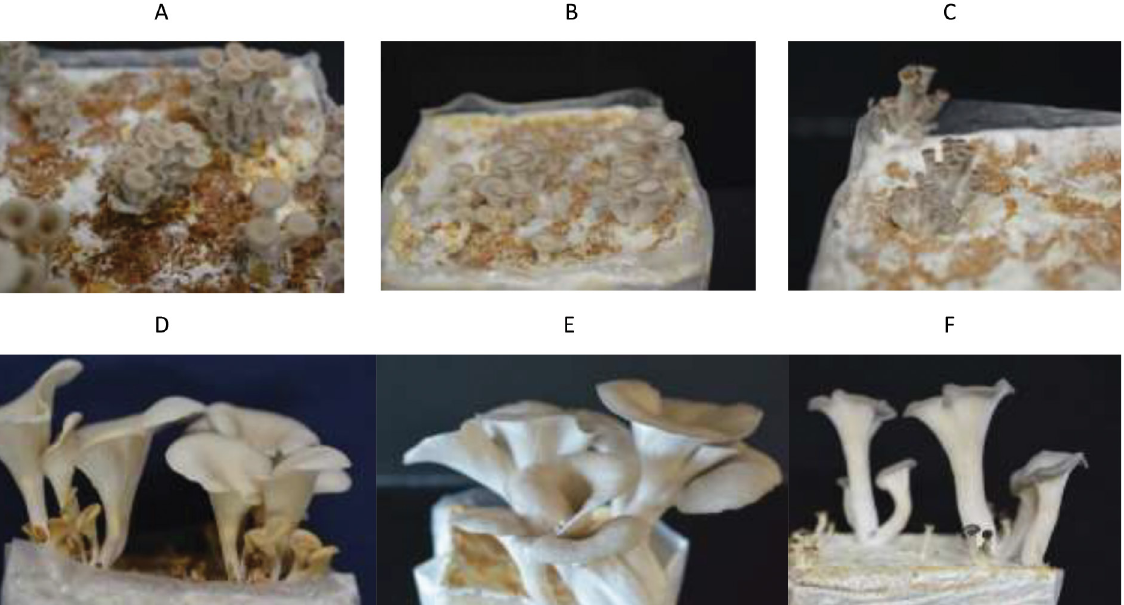
Fig. 1 Primordia (A, B, and C) and fruiting bodies (D, E, and F) of oyster mushroom ( P. ostreatus ) produced on the three sole substrates A and D are rice straw (RS): B and E are banana residues (BR): C and F are sorghum stalks